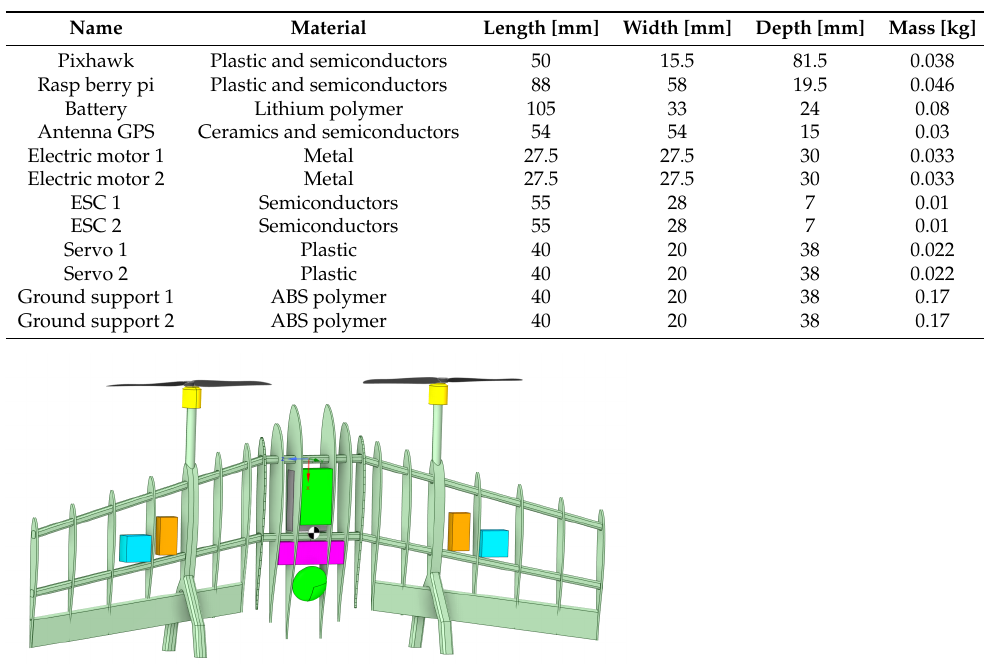
Table 3. Dimensional characteristics of the components.